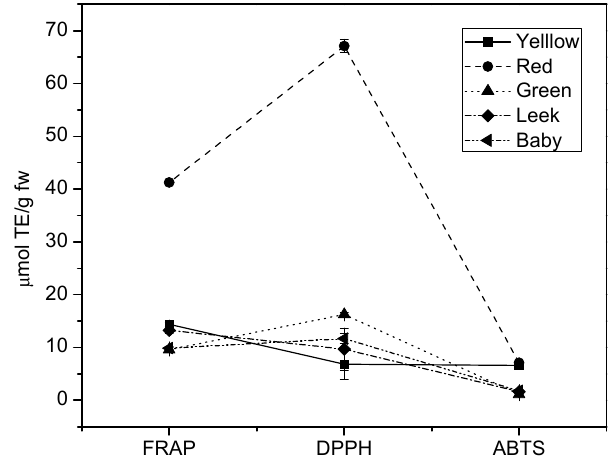
Figure 1. Antioxidant activities of onion varieties.